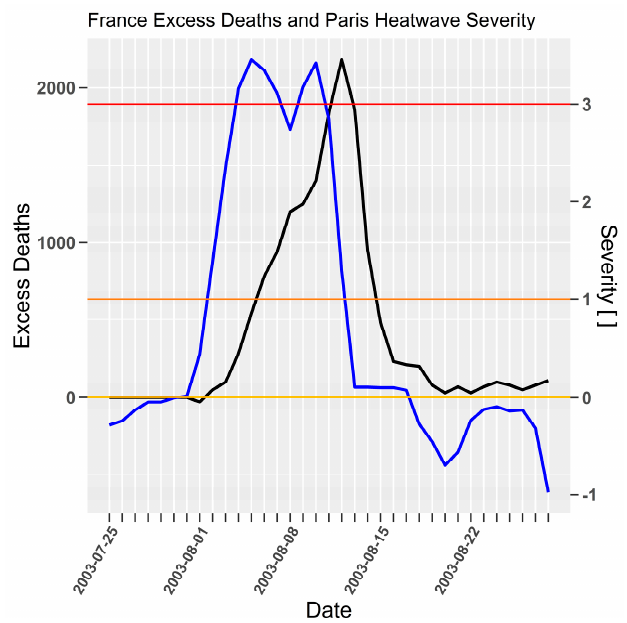
Figure 7. Paris severity (blue) and France excess mortality (black) for 2003 heatwave. Daily excess deaths (Poumadère et al. [39] (p. 1486, Figure 1)) and severity [] on left and right y -axes respectively.